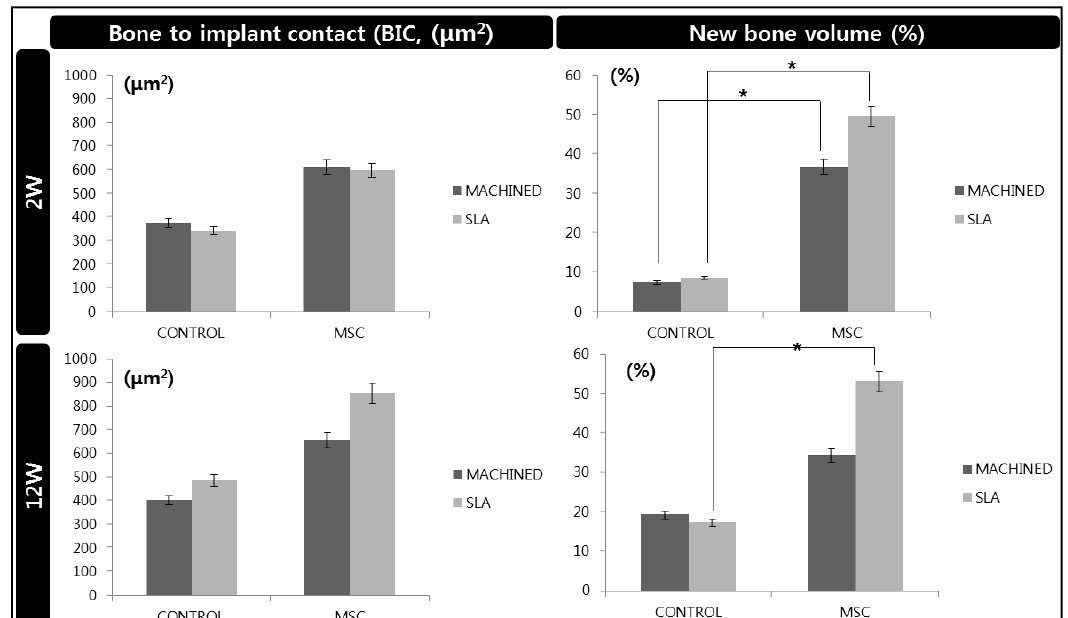
Figure 7. Light-microscopy views of the control group (without d-hMSCs) and the d-hMSCs group sacrificed at 2 and 12 weeks post-surgery (hematoxylin and eosin (H&E) stain, original magnification ×50, ×100; red circle indicates defect mar- gin.